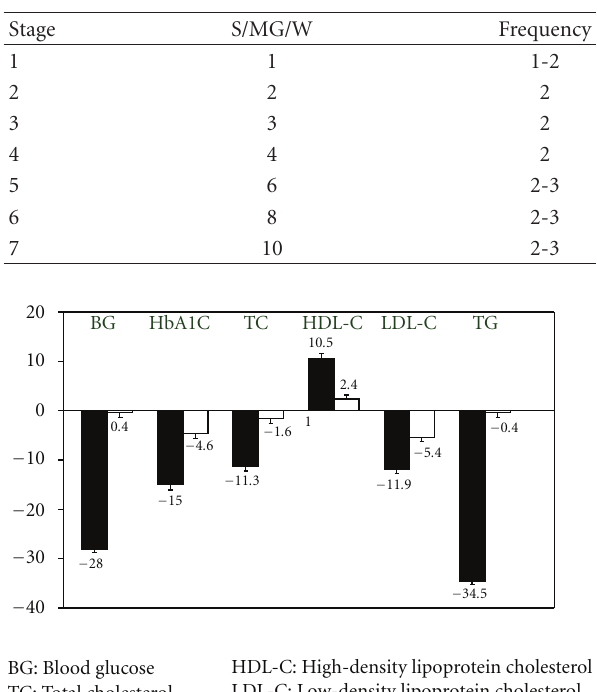
Table 1: Systematic adjustment of the weekly RT volume in sets per muscle group per week (S/MG/W) for improvement in maximum strength in rehabilitation, health, and leisure sports.